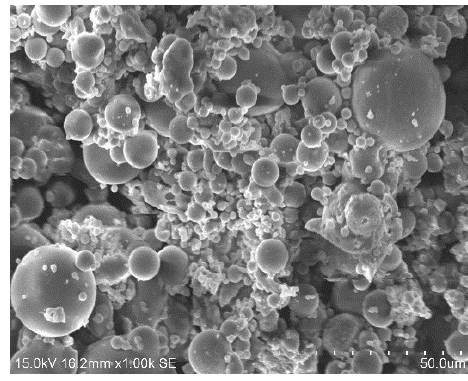
Figure 4. FESEM (Field emission scanning electron microscope) micrograph showing the morphology of fly ash particles. Table 3. Relevant parameters of fly ash from XRD.